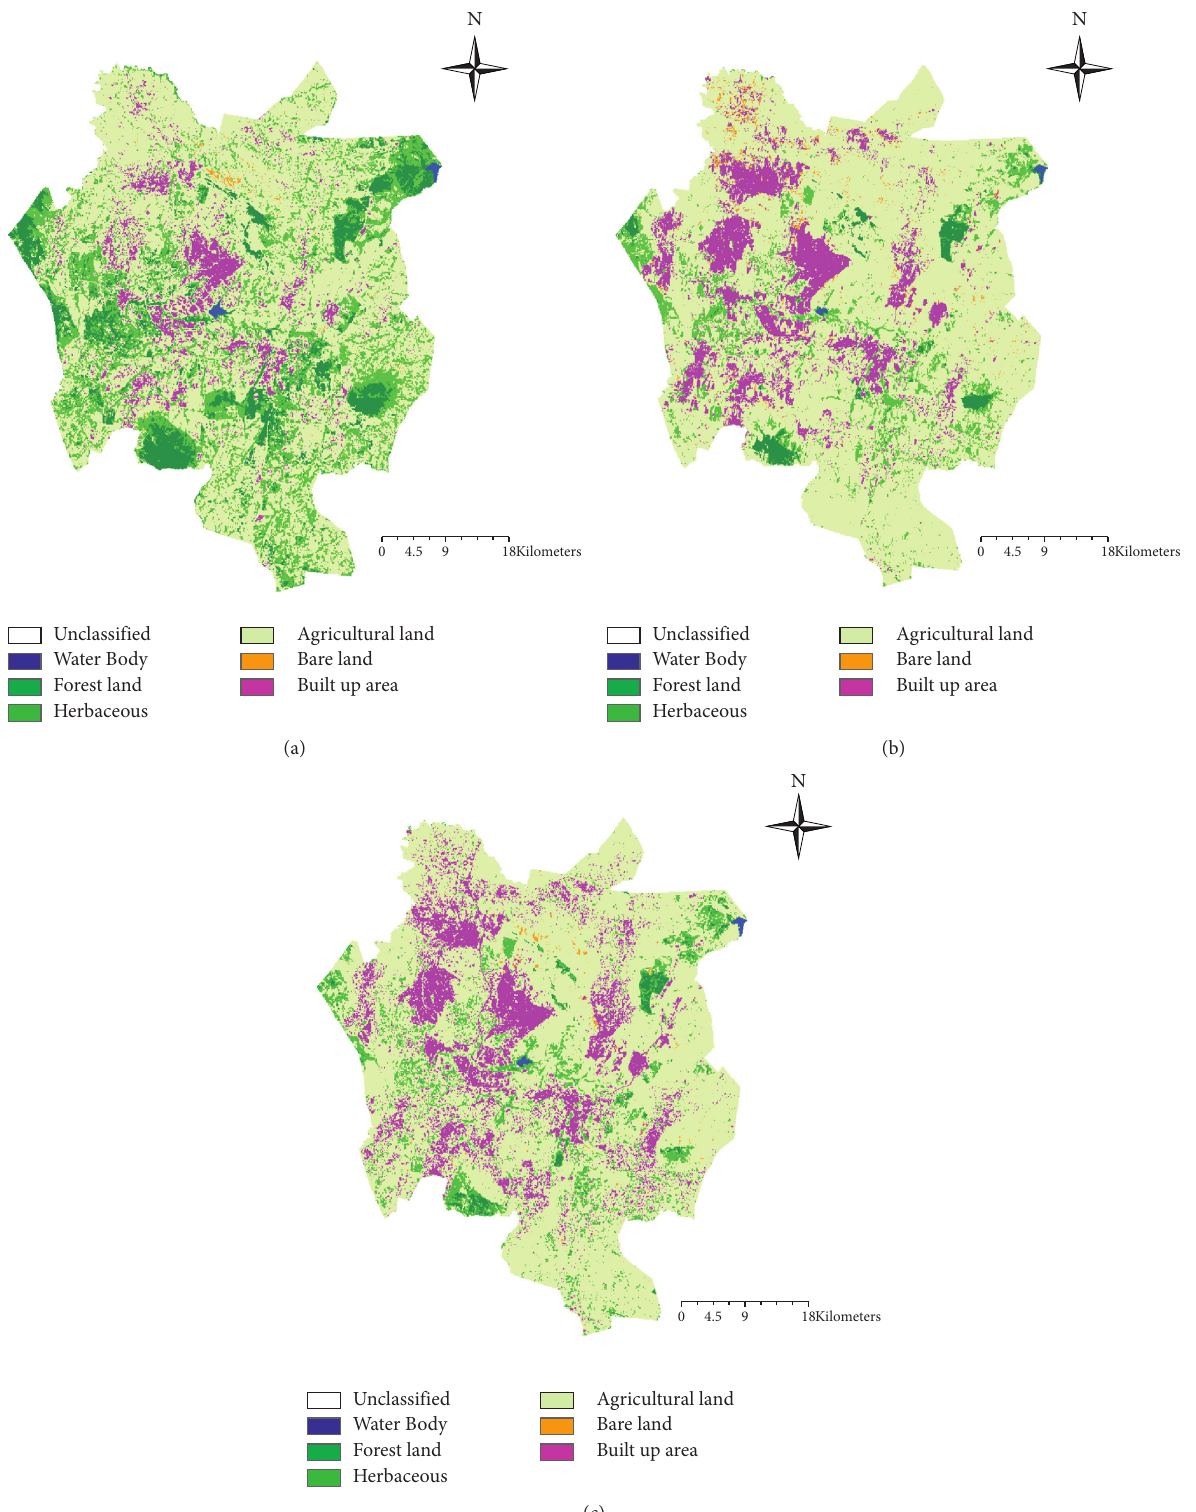
Figure 3: LULC map for (a) 1999, (b) 2010, and (c) 2019. Data source: satellite images courtesy of the US Geological Survey